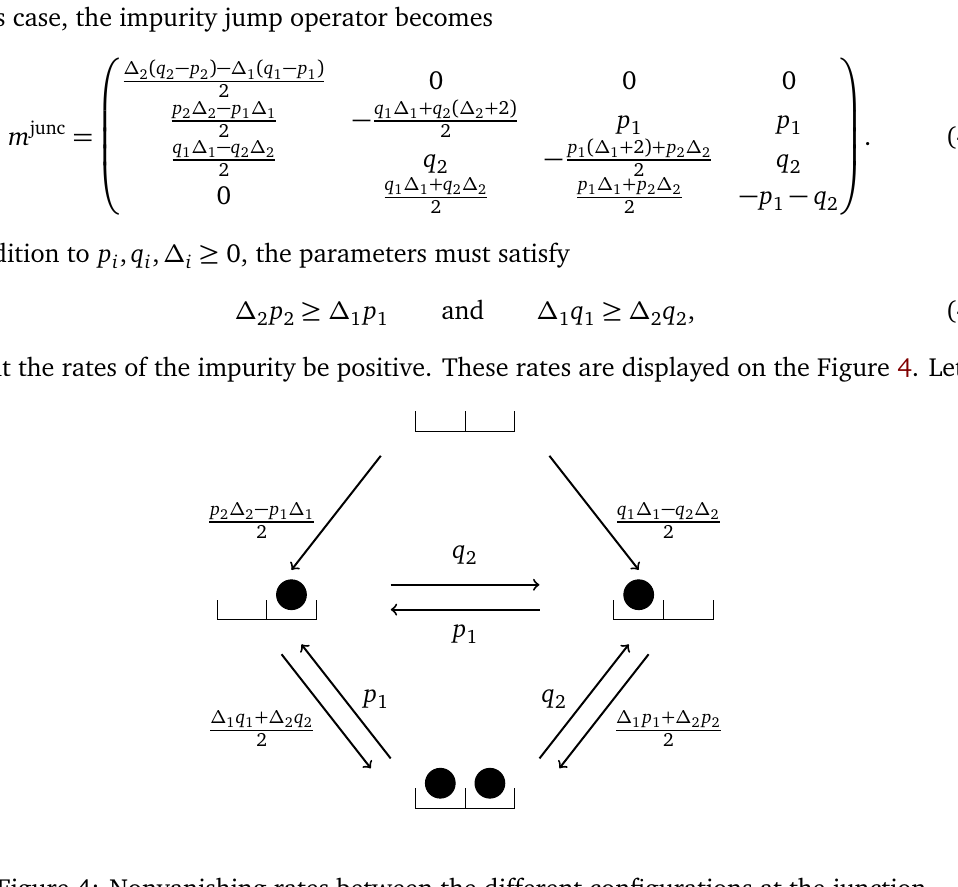
Figure 4: Nonvanishing rates between the different configurations at the